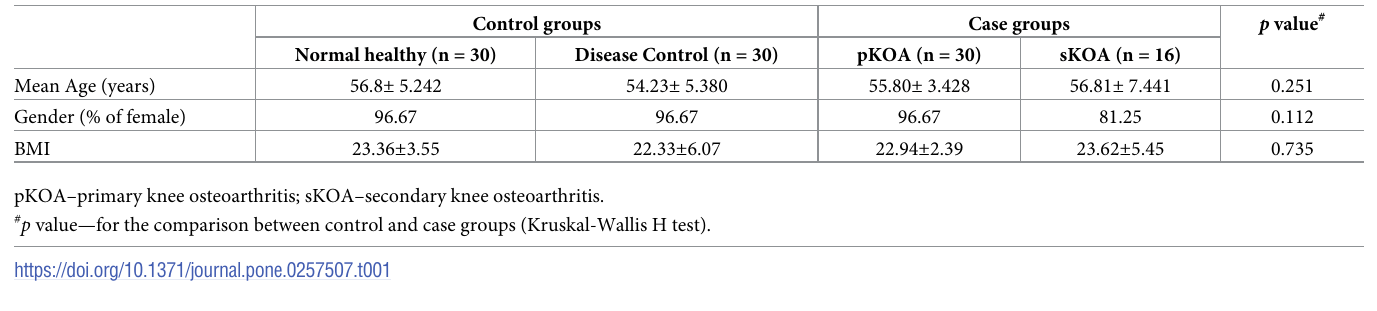
Table 1. General characteristics of the recruited control and case groups.